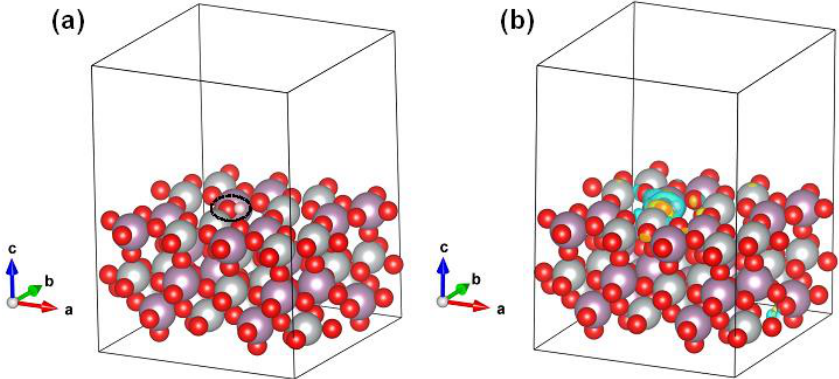
Figure 9. The optimized adsorption configurations of one HO molecule anchored on NiMoO 4 (110) surfaces with one surface oxygen vacancy (V o ), leading to an E ads of − 3.63 eV. The black dotted ellipsoid in ( a ) labels the position of the adsorbed HO molecule, which is at the vicinity of the V o . The yellow and cyan colors in the charge density difference contour ( b ) represent the electron accumulation and depletion, respectively. The isosurface level is 0.001 e bohr − 3